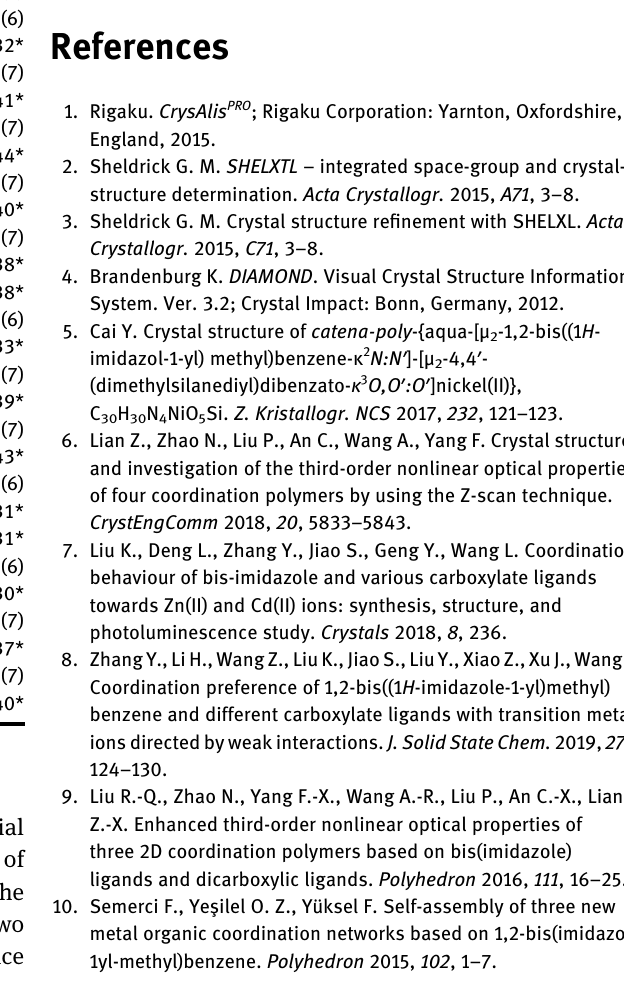
(2.014(2) and 1.989(2) Å, respectively) in the equatorial plane are shorter than the Cu1 – O1 bond length (2.590 Å) of the axis. A one dimensional polynuclear chain of the complex is formed by the connection of the ligand to two neighboring Cu(II) ions (see the Figure). The lattice